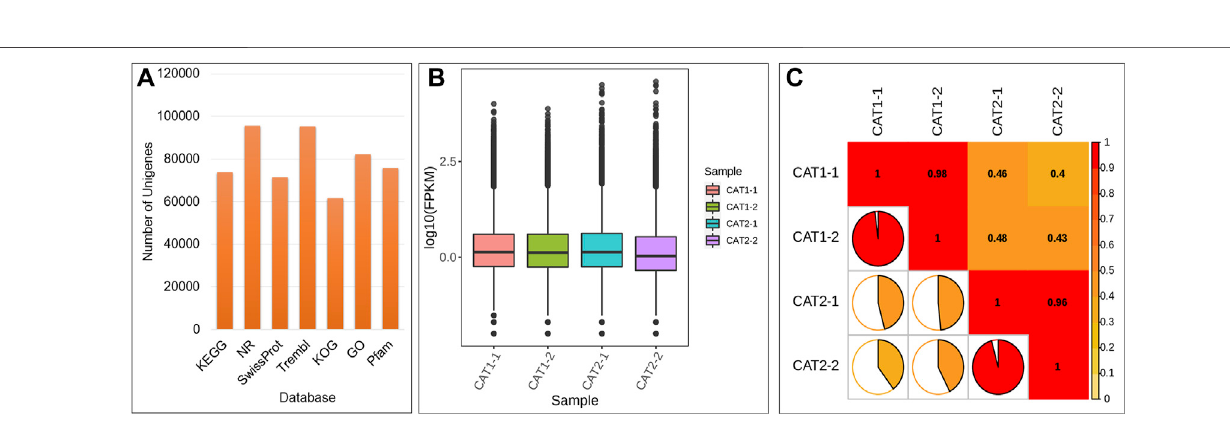
Frontiers in Genetics |